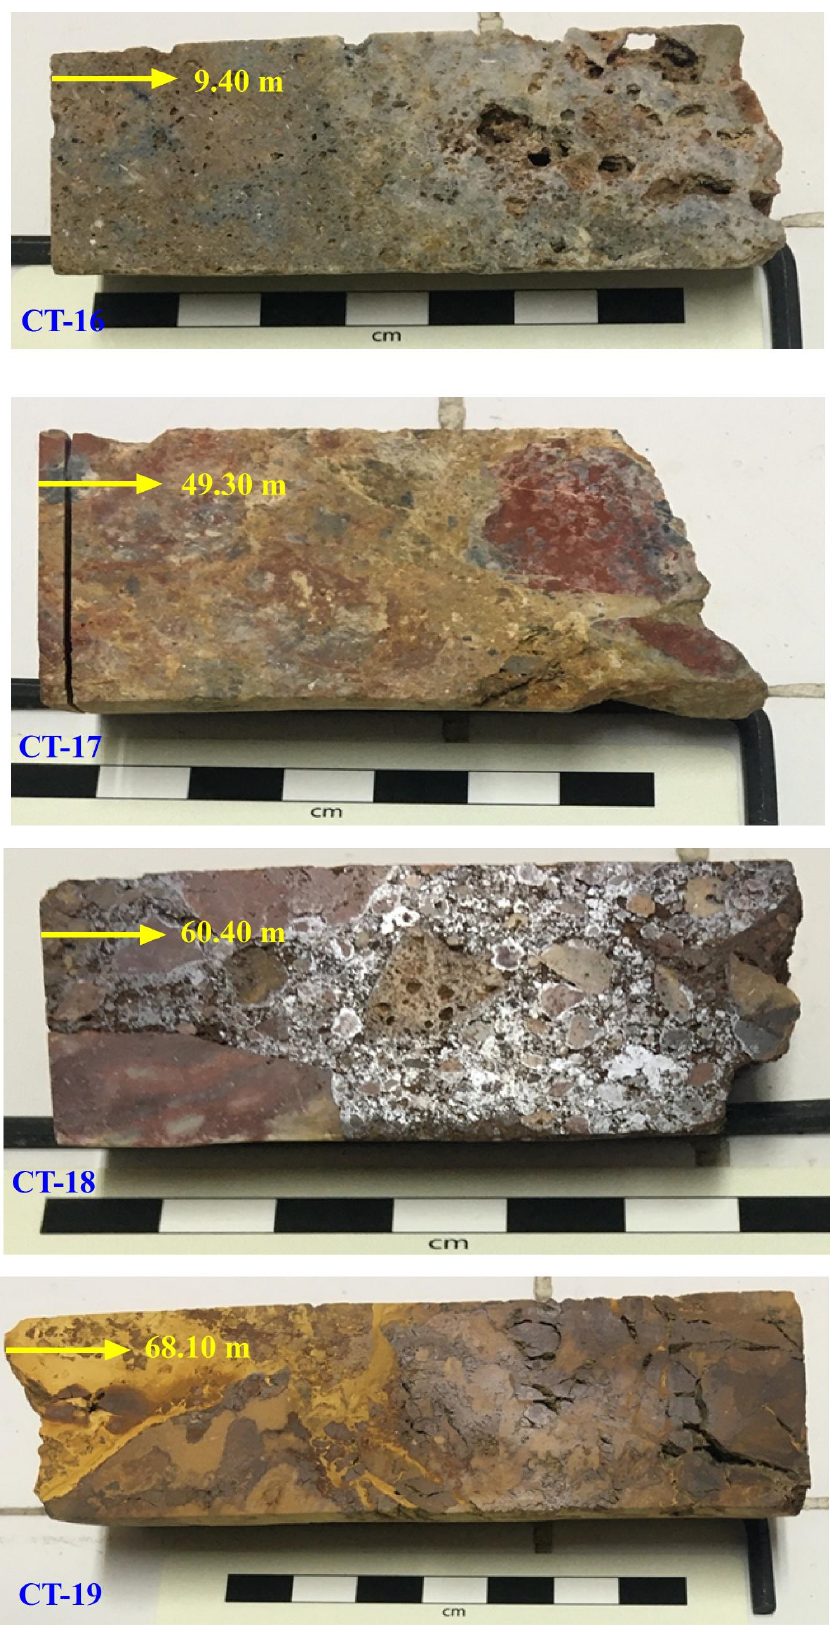
Figure 8. Close-up view of polished well log samples from gossan zone of Cerattepe VMSD, Drill core # CTD-190, at 1655